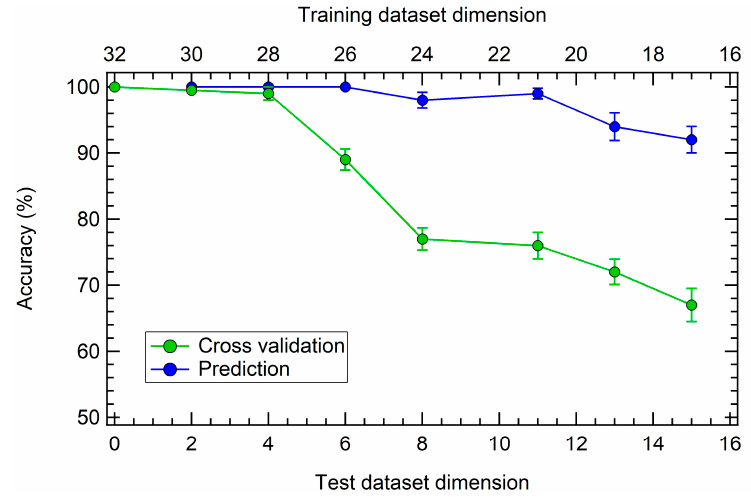
Figure 8. Accuracy percentage as function of the training ‐ test datasets dimension for internal cross validation (green dots) and prediction (blue dots). Bottom axis: test dataset dimension (N, with 0 < N < 16). Top axis: training dataset dimension (32 ‐ N).